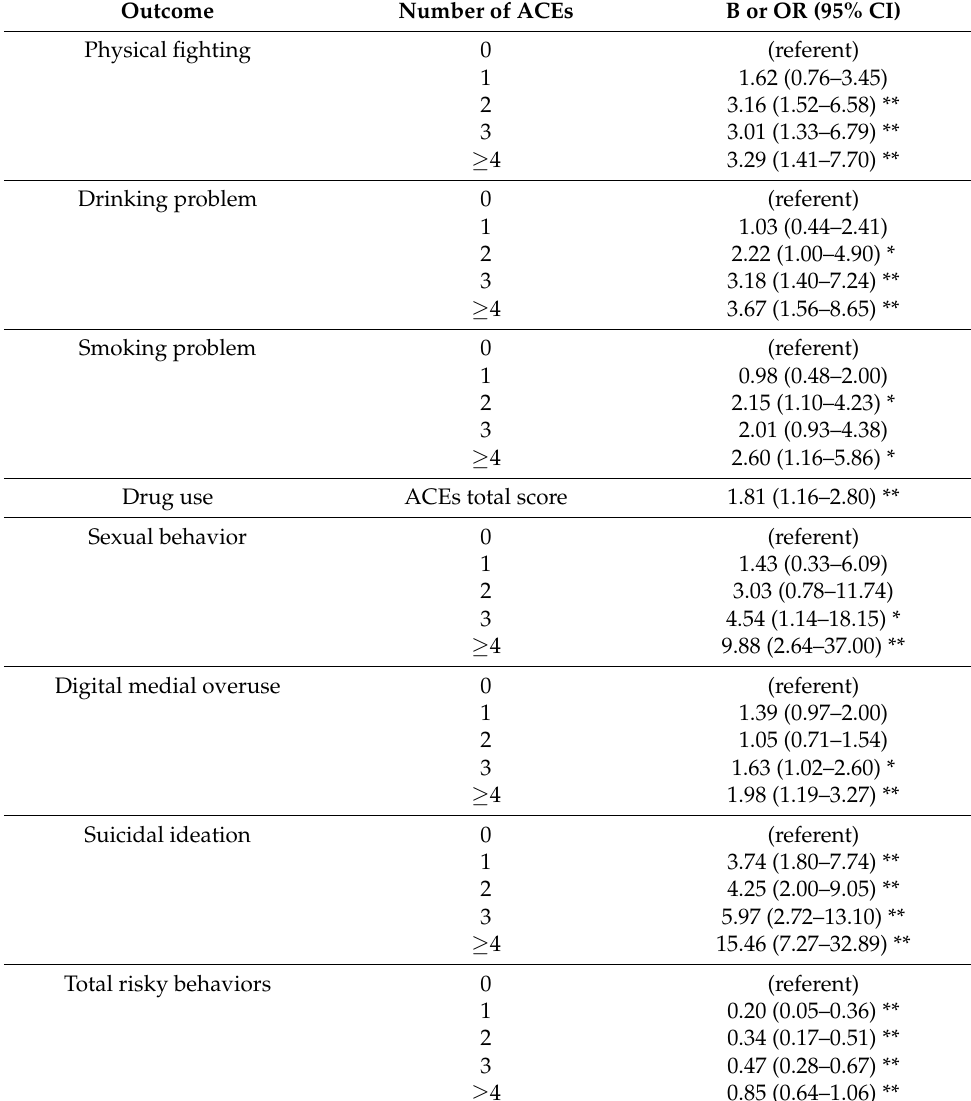
Table 3. Multivariate Analysis of Associations between ACEs and Risky